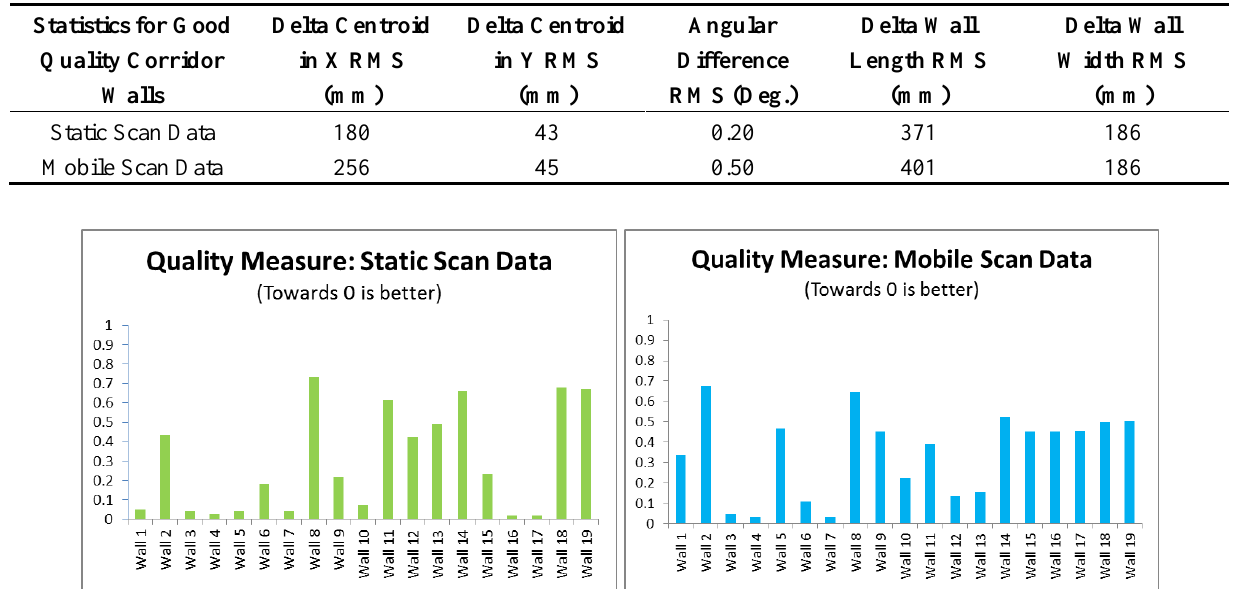
Table 2. Statistics for the accuracy of the same reconstructed corridor walls considered good quality from both datasets (walls 3, 4 and 7) against the reference.